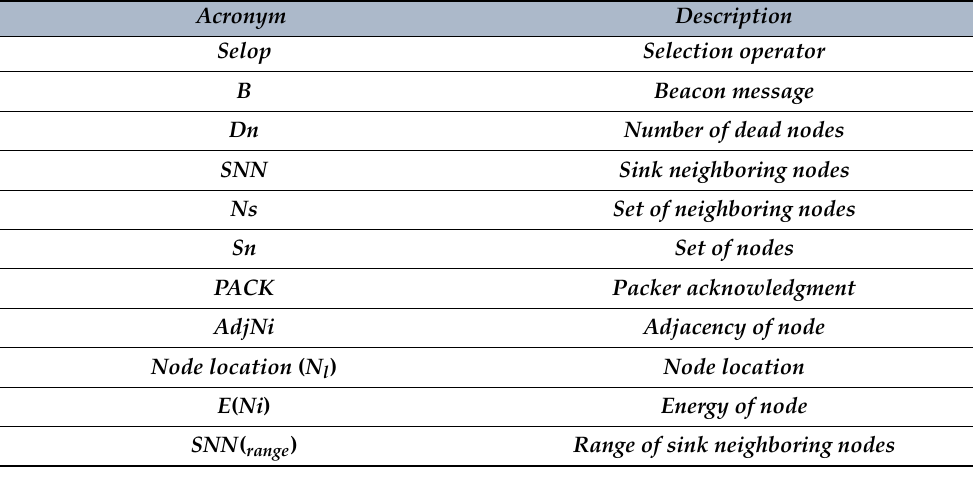
Table 1. Acronyms and their